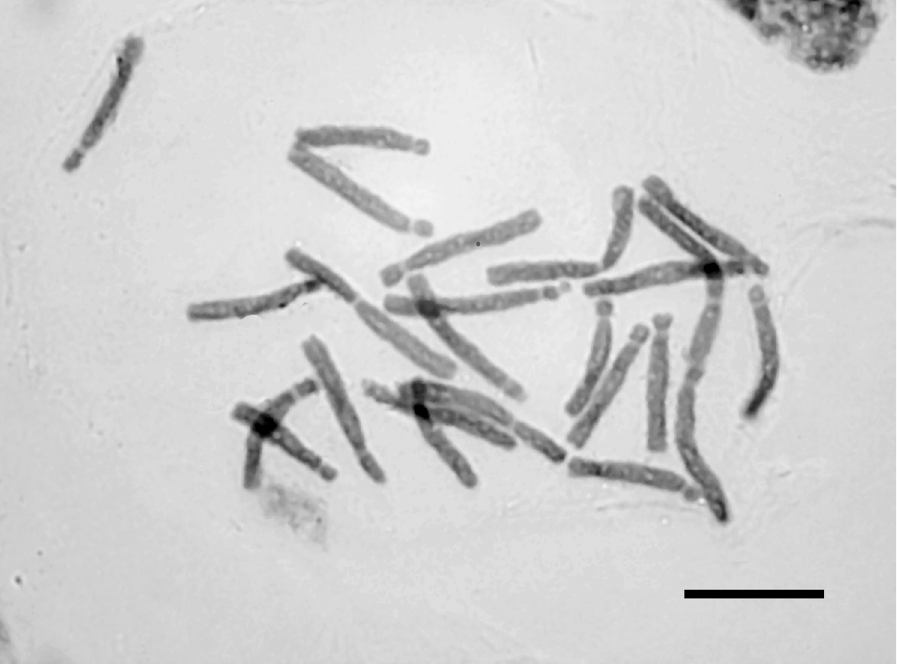
Figure 5. Photomicrograph of mitotic metaphase plate of Fritillaria epirotica from Mt. Smolikas, 2n = 2x = 24. Bar = 10 µm.